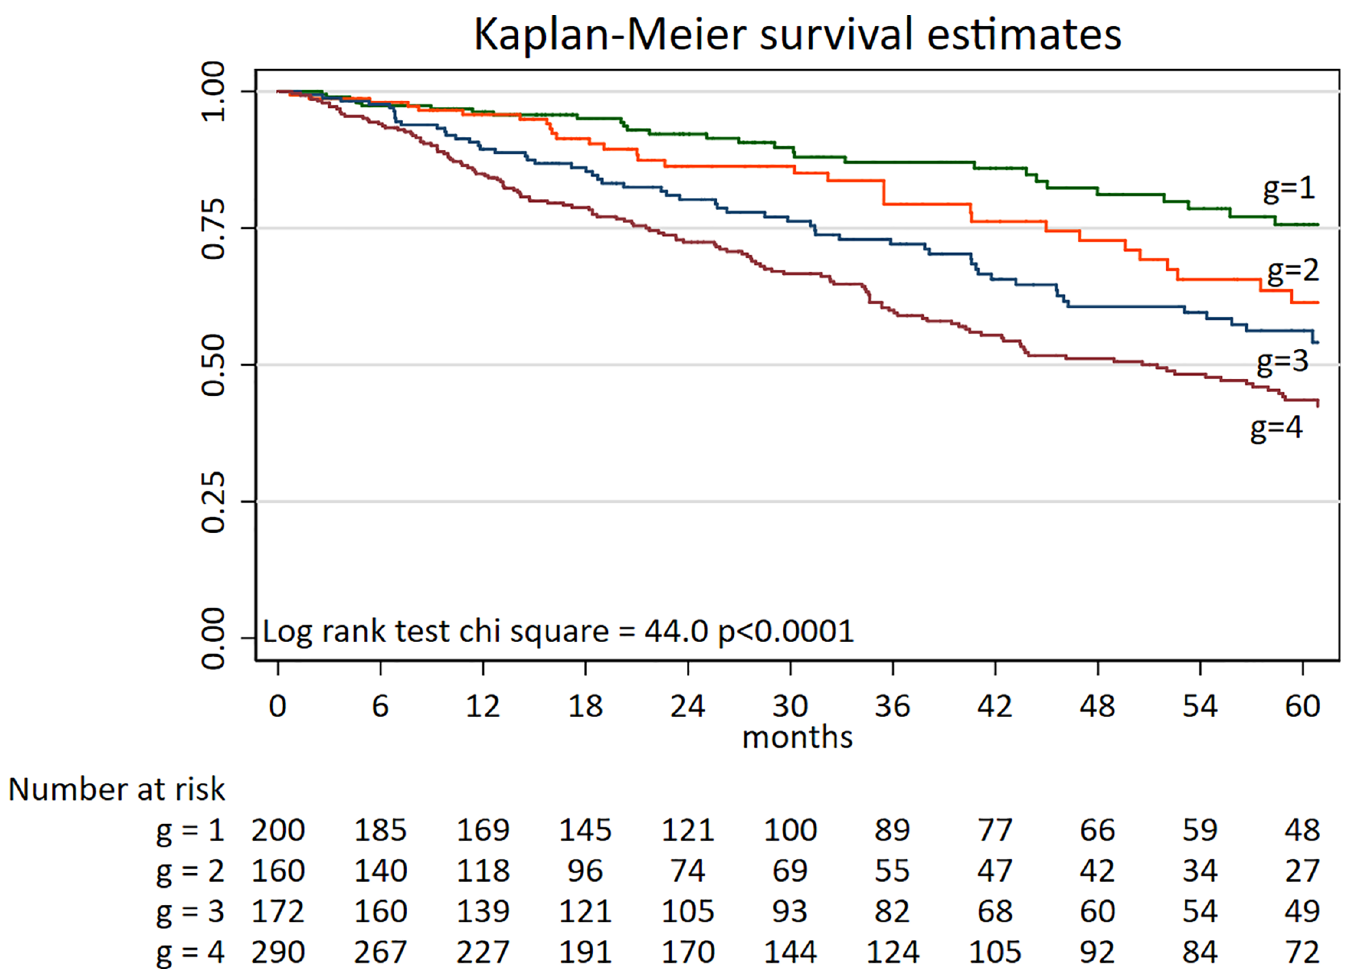
Fig 2. Kaplan-Meier survival curves during 60 months follow-up in 822 CKD stage 5 patients divided into four groups according to levels of hsCRP (high (cid:21) 3mg/L, or normal < 3mg/L) and S-Alb (low < 35 g/L, or normal (cid:21) 35g/L). Group 1 (n = 200): Normal S-Alb and normal hsCRP; Group 2 (n = 160): Low S-Alb and normal hsCRP; Group 3 (n = 172): Normal S-Alb and high hsCRP; Group 4 (n = 290) Low S-Alb and high hsCRP.